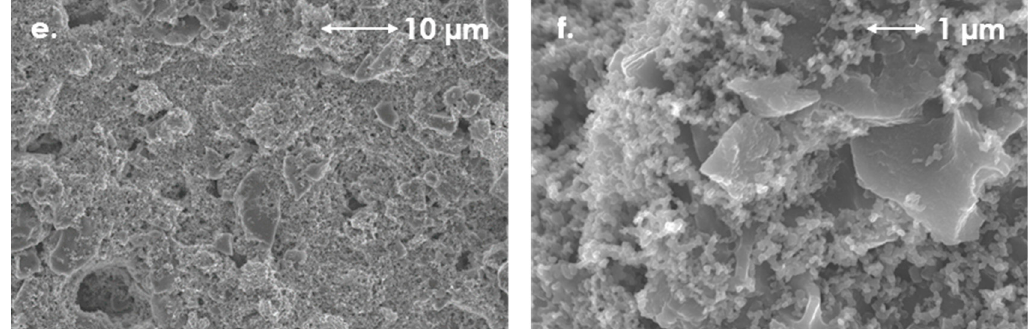
Figure 3. SEM images of electrodes with different binders: starch ( a , b ), PTFE ( c , d ) and CMC ( e , f ), at different magnifications (scale added to the images). Composition of electrode material 80 wt. % activated carbon (YP 80F) 10 wt. % carbon black (Super C65) and 10 wt. % binder.